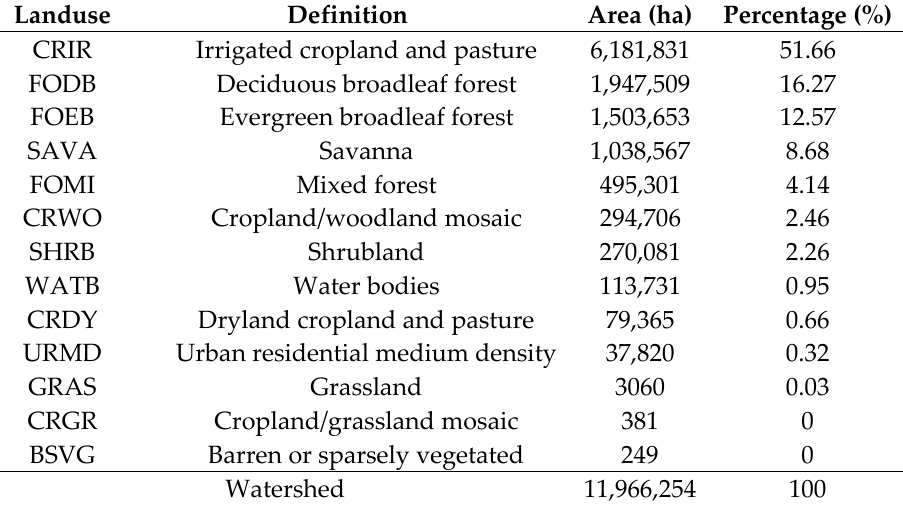
Table 1. Area and percentage of land cover in the Chao Phraya River